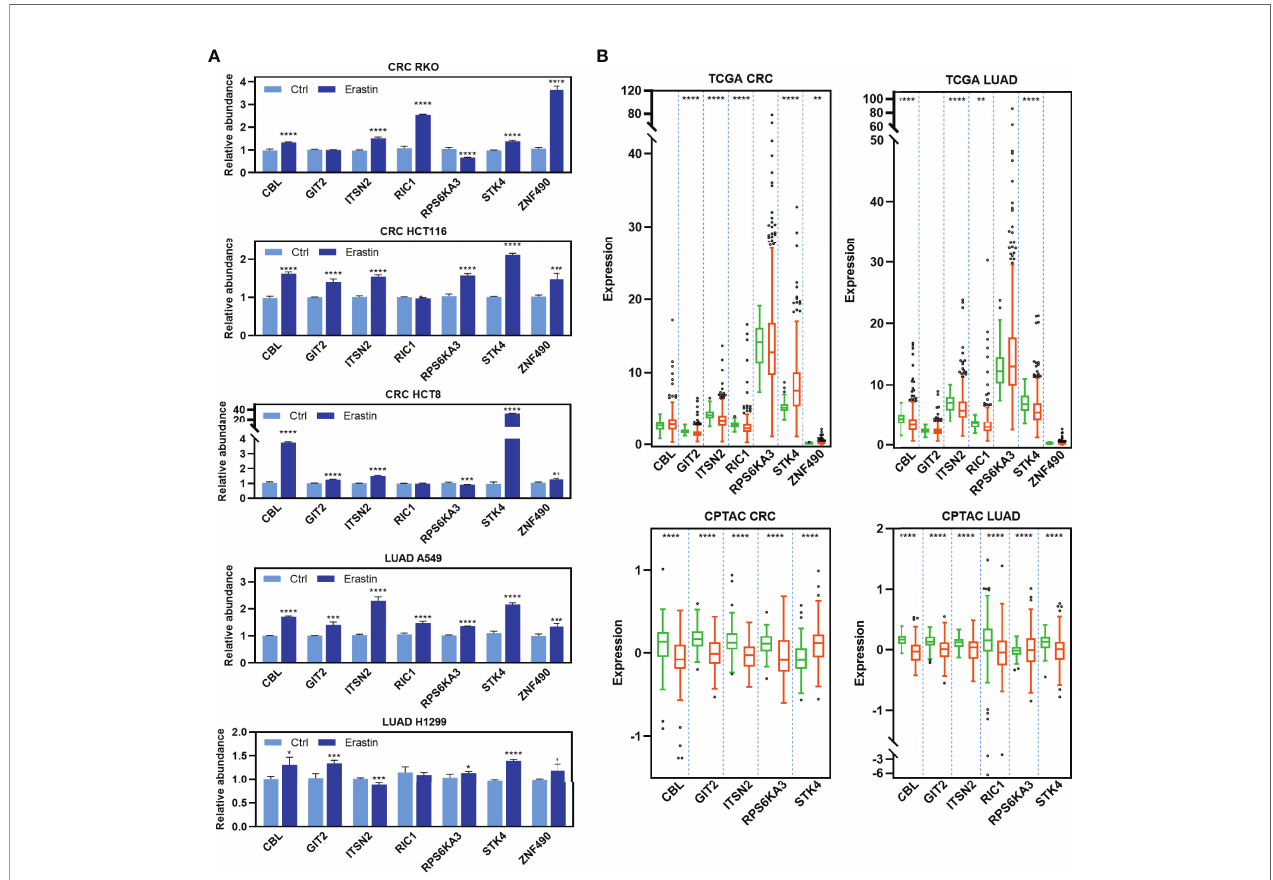
FIGURE 4 | Functional validation of RFL-correlated genes. (A) Barplots showing expression levels of seven candidate RFL-correlated genes after Erastin treatment in fi ve cancer cell lines. (B) Box plots showing expression levels of seven candidate RFL-correlated genes grouped by tumor and normal samples in the TCGA (mRNA) and CPTAC (protein) cohorts. *P< 0.05, **P < 0.01, ***P <0.001, ****P <